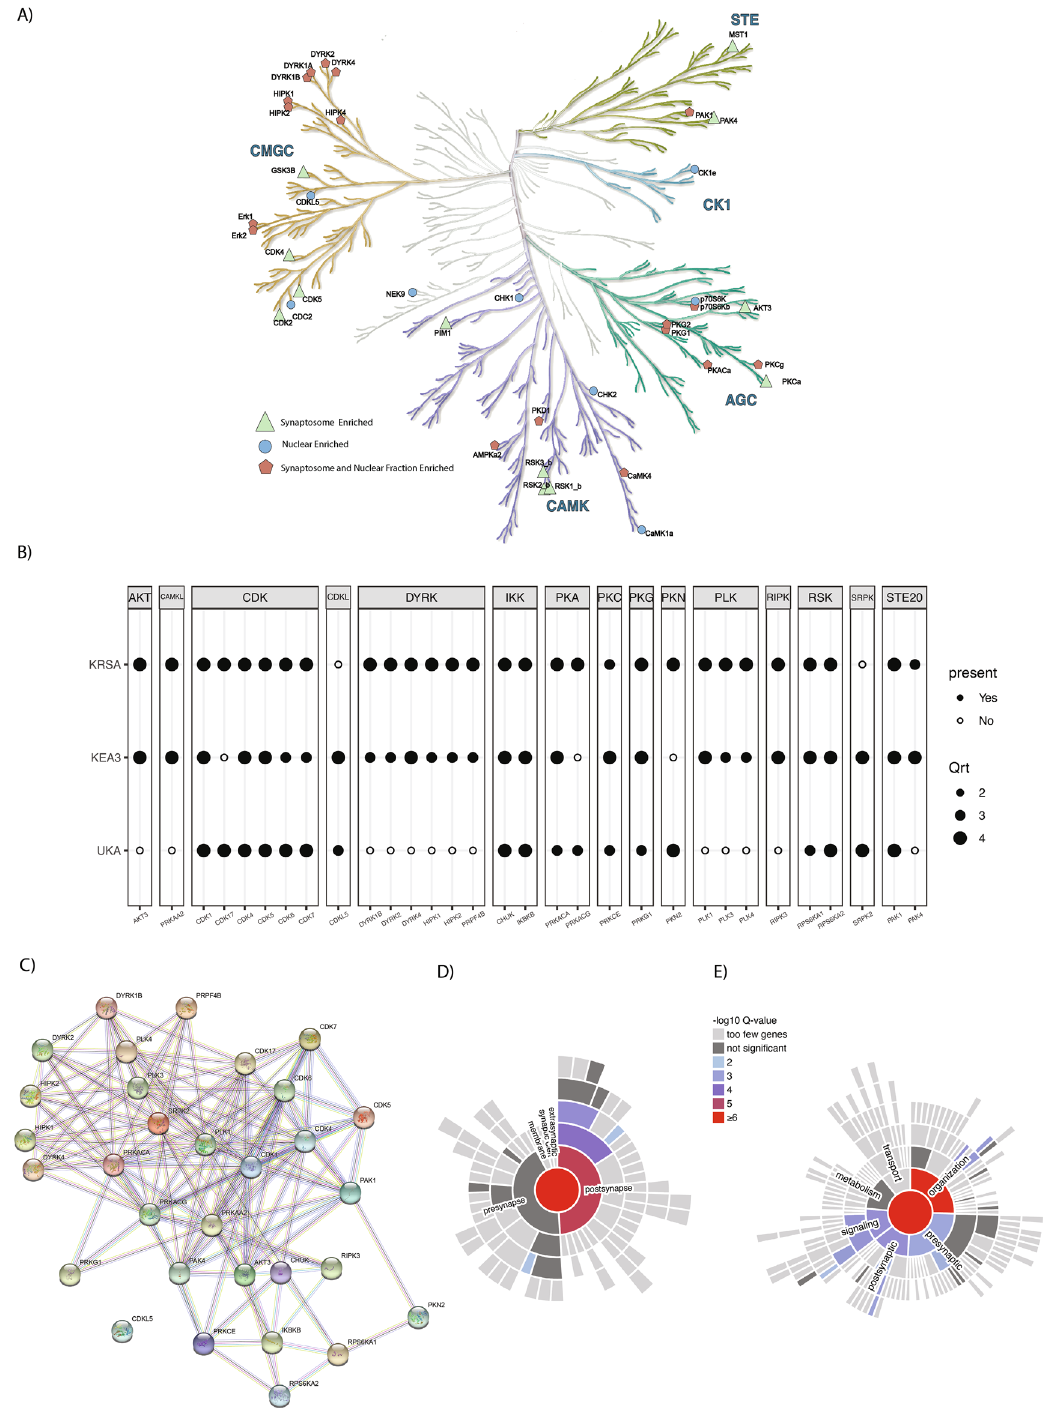
Figure 4. Upstream Kinase Analysis Shows a Subset of Kinases That are Actively Enriched in the Synaptosome. Using three software packages to perform upstream kinase analyses (KRSA, KEA3, and UKA), we harmonized the outputs from each tool with percentile ranking and a centralized kinome mapping reference. Criteria to select top kinases: kinase must be included in at least two tools and the mean percentile (the mean percentile is calculated by averaging the percentile ranks across all the three tools) must be > = 0.75. ( A ) The full kinome phylogenetic tree and highlighting the top enriched kinases in each subcellular fraction (synaptosome and nuclear). The comparisons are performed with the cytosol fraction treated as the reference sample. ( B ) Top enriched kinases when comparing the nuclear and synaptosomal fractions. For visualization, the percentile values are grouped as quartiles. ( C ) STRING DB protein– protein interaction (PPI) network of the top enriched kinases when comparing the synaptosomal versus nuclear fractions. Minimum required interaction score was set as 0.2. ( D – E ) The SynGo gene set enrichment analysis of the top differentially active kinase networks. The protein networks are generated by extracting top 20 associated proteins from STRING (minimum required interaction score was set as 0.5). The plots are showing the top-levels Cellular Component ontology ( D ) and Biological Process ontology ( E ) terms visualized as “sunburst” plots to represent the adjusted enrichments scores (FDR) for each parent and child term. KRSA: Kinome Random Sampling Analyzer, KEA3: Kinase Enrichment Analysis, UKA: Upstream Kinase